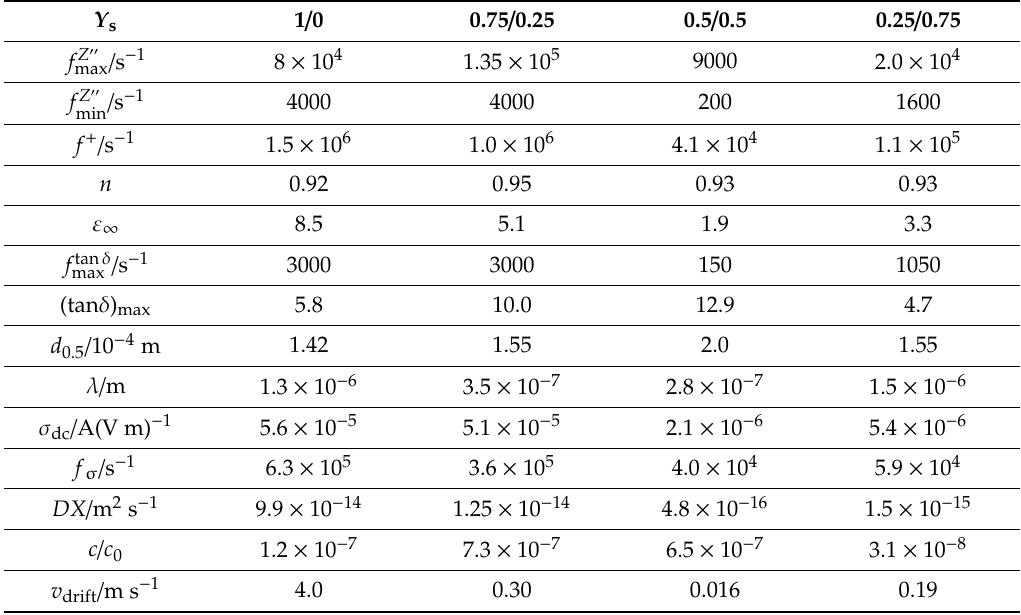
Table A2. Characteristic quantities of PEO / PMMA blends with Y S = 0.1 at 298